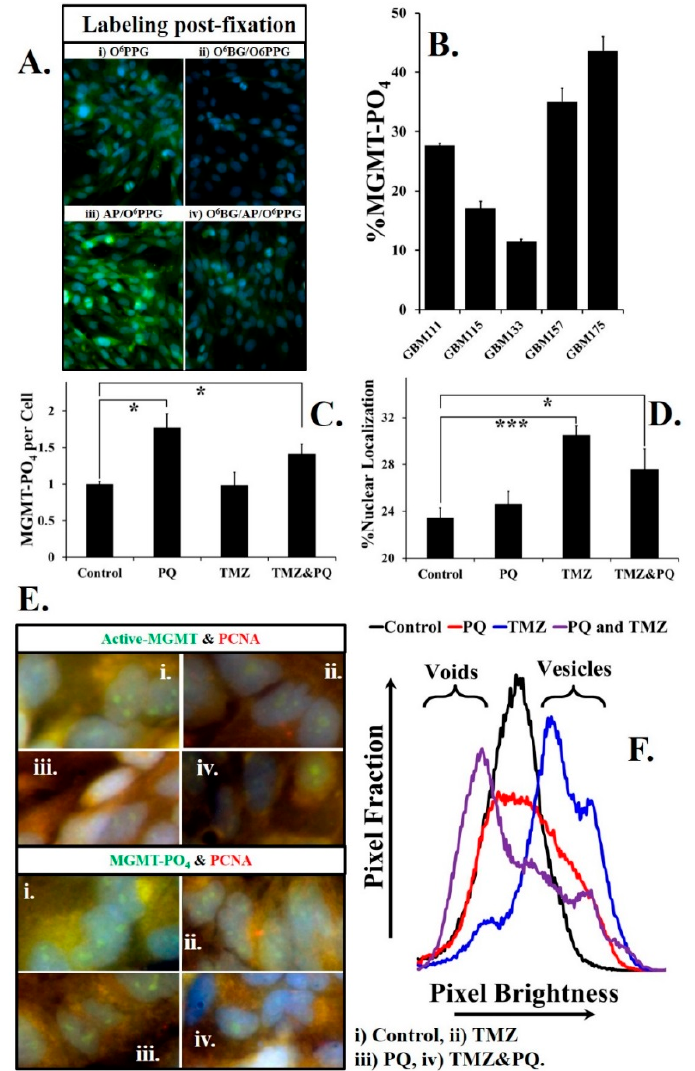
Figure 6. Phosphorylated MGMT in fixed cells can be labeled after reactivation by alkaline phosphatase. ( A ) (i) GBM157 cells labeled using O 6 PGG; (ii) treatment with MGMT inhibitor O 6 BG eliminates the O 6 PGG labeling of MGMT; (iii) pre-treatment of GBM157 cells with alkaline phosphatase (AP) increases MGMT labeling compared to control because of the conversion of phosphorylated MGMT into active MGMT; (iv) reactivation of phosphorylated (inactive) MGMT by AP in cells pre-treated with the MGMT inhibitor O 6 BG. ( B ) The fraction of phosphorylated (inactive) MGMT in different primary GBM cell lines show significant variations, and may reflect tumor heterogeneity; also see Supplementary Figure S3. ( C ) Statistically significant ( t -test) increases in phosphorylated (inactive) MGMT levels occur upon treating GBM157 cells with either paraquat (PQ), or TMZ, or a combination of PQ and TMZ. ( D ) Statistically significant increases in phosphorylated (inactive) MGMT levels occur upon treating GBM157 cells with TMZ or a combination of PQ and TMZ. ( E ) Proliferating cell nuclear antigen (PCNA) levels were measured using a fluorescently labeled PCNA antibody. Active MGMT levels were measured using O 6 PGG / azido-PEG-FITC / click. Levels of phosphorylated (inactive) MGMT were measured by pre-treating GBM157 cells with O 6 BG followed by treatment with alkaline phosphatase and labeling using O 6 PGG / azido-PEG-FITC / click. ( F ) Analysis of the distribution of PCNA labeled pixels in the GBM157 nuclei. Treatment of GBM157 cells with PQ or TMZ or a combination of PQ and TMZ changes the line shape, indicating higher localization in nuclear vesicles in response to DNA damage.* p < 0.05, *** p <